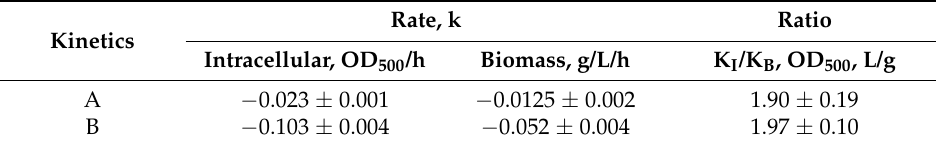
Table 1. Intracellular realising (K I ), biomass decay (K B ) rates from 120 h to 168 h of fermentation kinetics and K I / K B ratio. ( A ) Control, without surfactant; ( B ) Addition of Triton X-100.